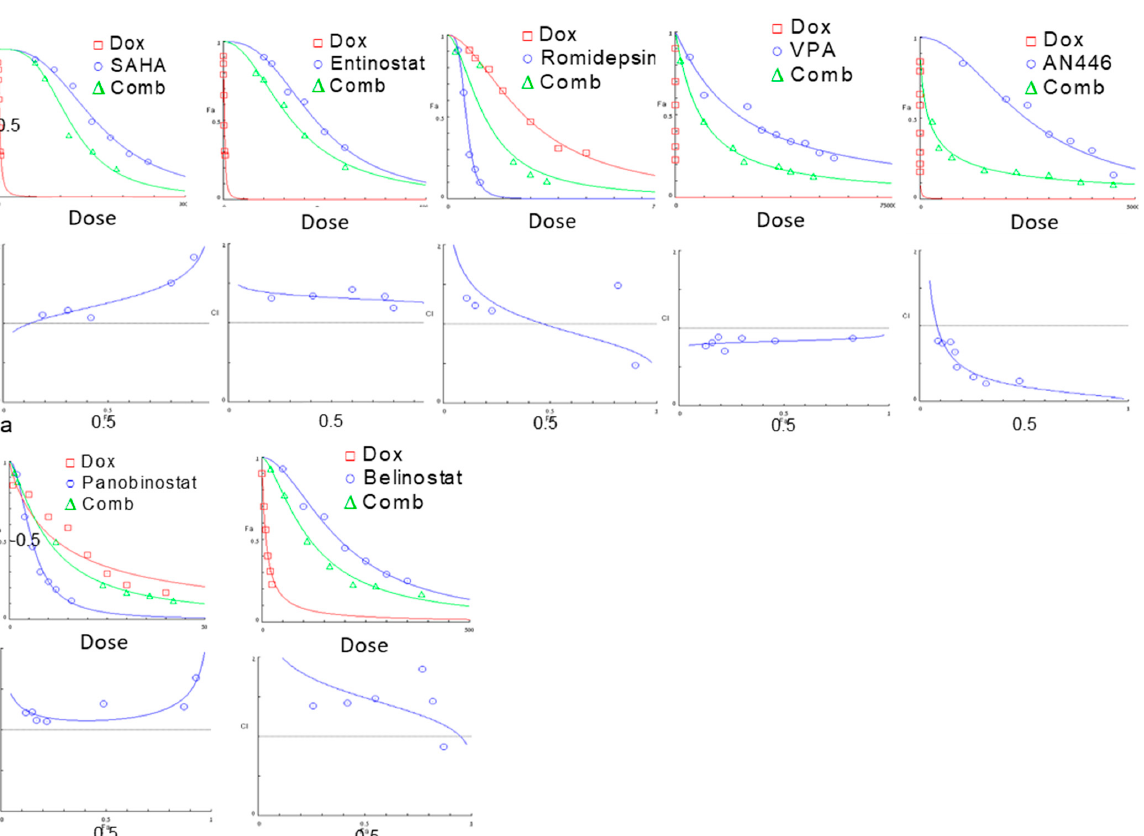
Figure 1. Effect of HDACIs, Dox, or their combinations on the viability of 4T1 murine breast cell line. 4T1 cells (4 × 10 3 /well) were seeded in 96 well-plates, incubated overnight, and then treated with SAHA (0.1–3 µ M), entinostat (0.1–3 µ M), Rom (0.1–3 nM), VPA (1–10 mM), AN446 (10–60 μ M), panobinostat (1–20 nM), belinostat (50–400 nM), or Dox (1–40 nM), or their IC 50 combination. After 72 h of treatment. the viability of the cells was determined by the Hoechst assay. The average values of three independent experiments are presented. The drug concentrations ‐ dependence plots were generated for each of the drugs alone and in combination with Dox. The fraction of affected cells (Fa) as a function of Dox concentrations or HDAC inhibitor concentrations as a single agent and their combination are presented; CIs as a function of Fa in 4T1 cells were produced by CompuSyn software are shown. The IC 50 value of each drug as a single agent and in combination with Dox and the calculated combination index (CI) are shown. Each treatment was performed in triplicate in three independent experiments and is presented as the mean ± SE. Table 1. Values of IC 50 for each of the indicated drug as a single agent and in combination with Dox.